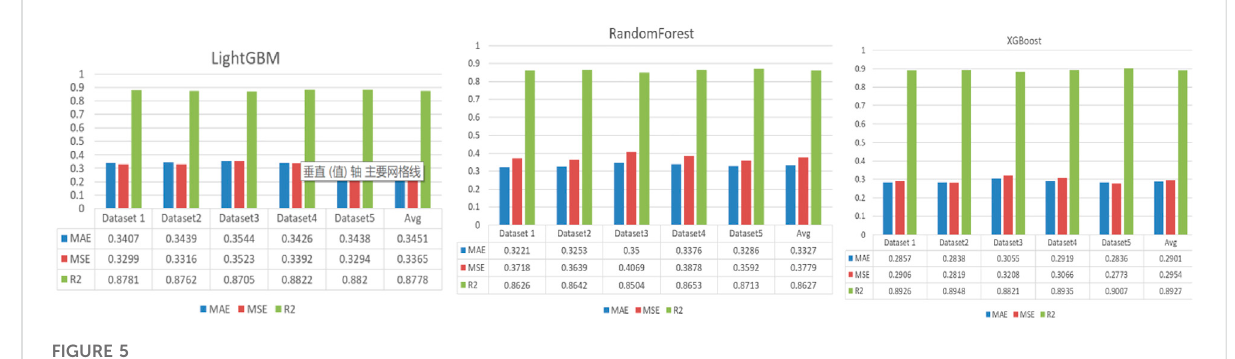
FIGURE 4 XGBoost 10-fold ROC.